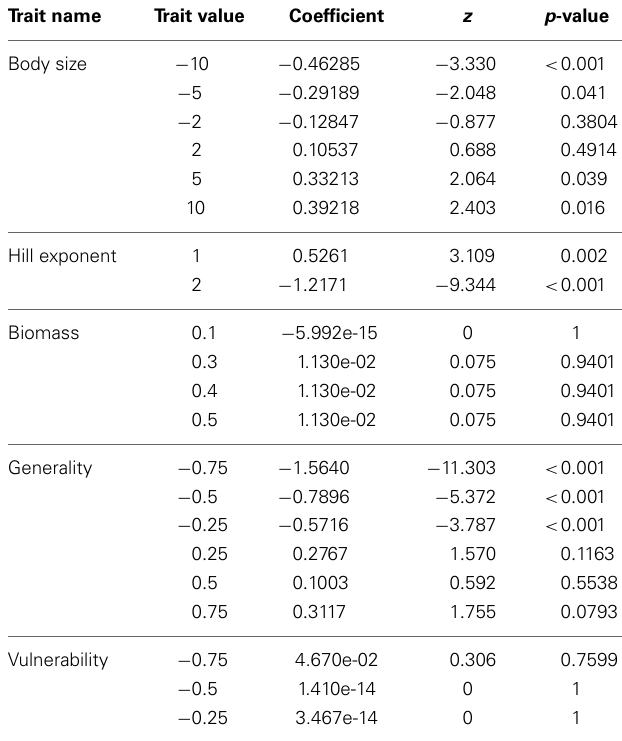
GLMs results presented correspond to the difference between the trait values on the table and the default value for each trait respectively (see text). Food web connectance was included into the GLM as a fixed factor. Values for each trait are defined in the caption of Figure 3 and Methods. The sign of the coef- ficient value represents the directionality of the relationship between that trait and the fraction of invasion success. Degrees of freedom for the models mea- suring the effect of body size = 7321, hill exponent = 3137, biomass = 5229, generality = 6964, and vulnerability =